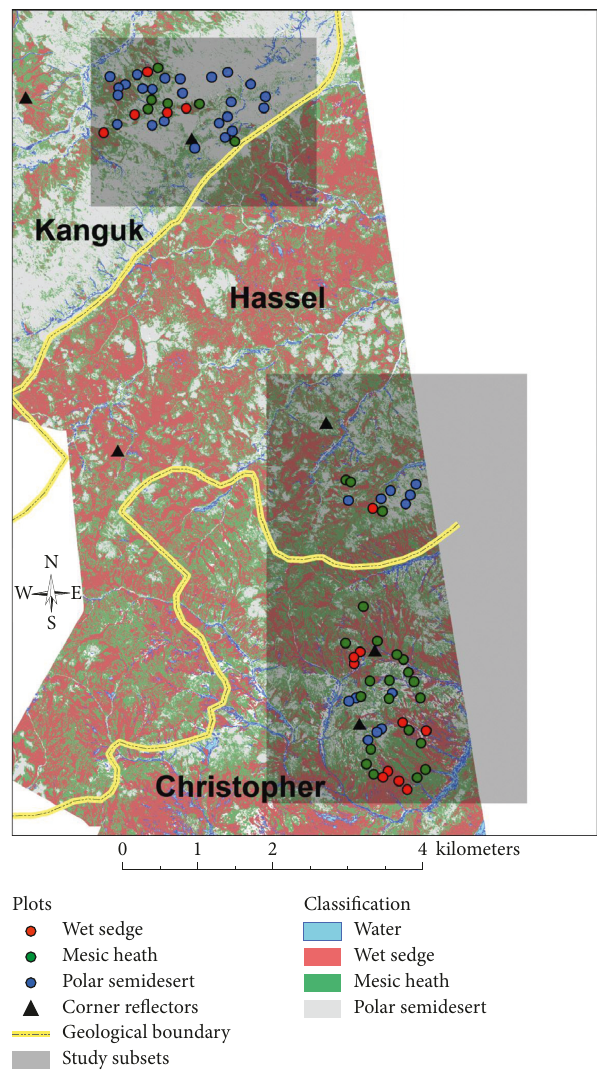
Figure 3: Unsupervised classification, study plots, and geological boundaries for the Cape Bounty Arctic Watershed